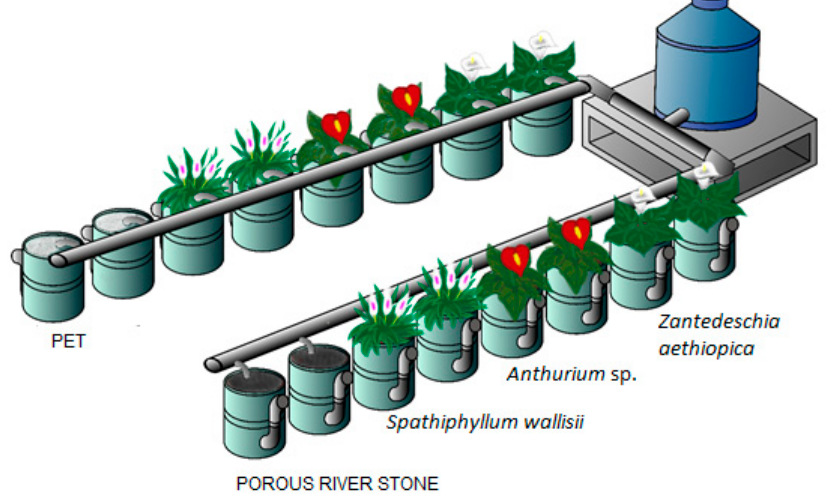
Figure 1. Configuration of wasteland microcosm.